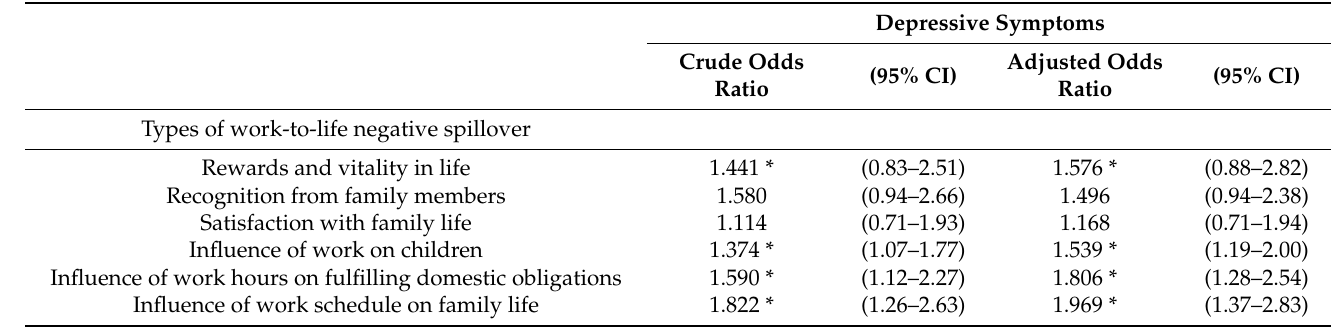
Table 3. Association between work-to-life negative spillover and depressive symptoms.